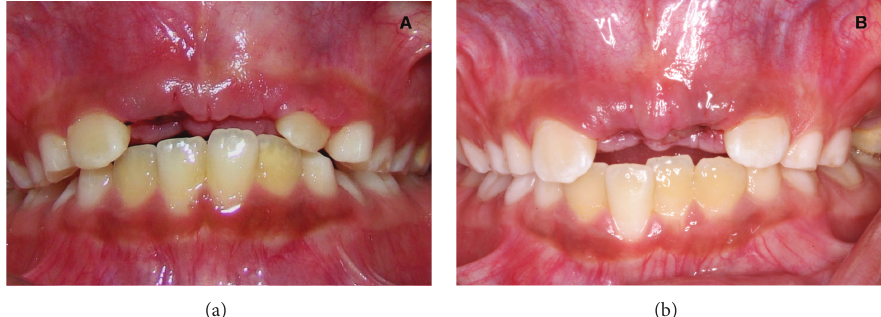
Figure 5: Intraoral view showing the intraoral aspect after 1 week of the mesiodens removal in both twins.